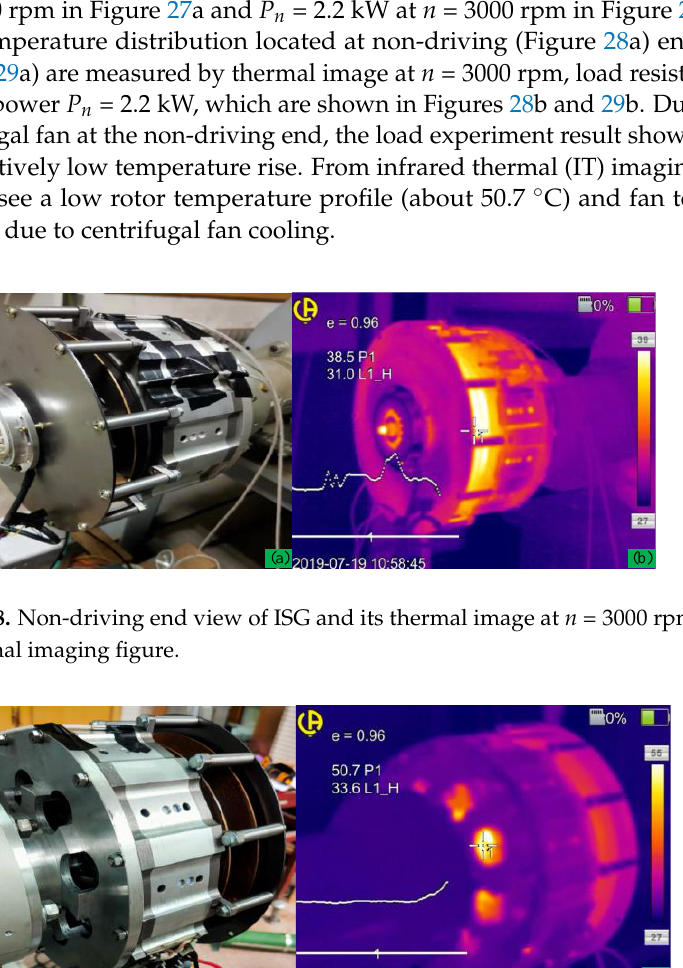
Figure 27. Bus current, bus voltage, and output power wave. ( a ) Speed n = 1000 rpm, ( b ) speed n = 3000 rpm.